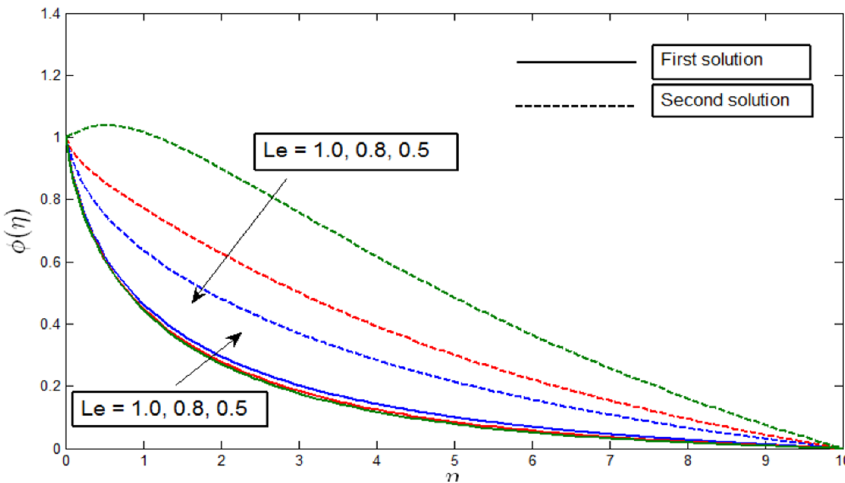
Figure 10. Concentration profile φ(η) for various Le when (cid:31) = − 4, γ = 5, Lb = 0.5, Pb = 0.5, Nr = 0.5, Rb = 0.6, A = 0.2.